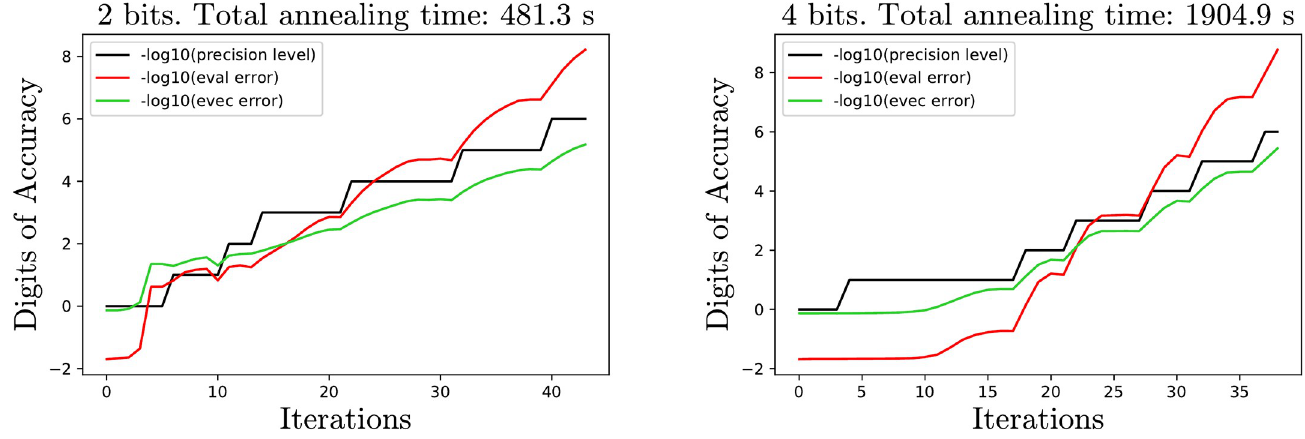
Fig 2. Error plot for 560 × 560 space Shuttle control matrix.